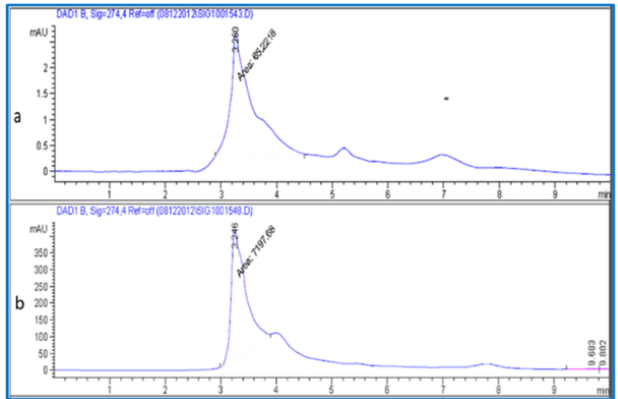
Figure 4. HPLC chromatogram ( a ) Maltose standard and ( b ) maltose from fruit